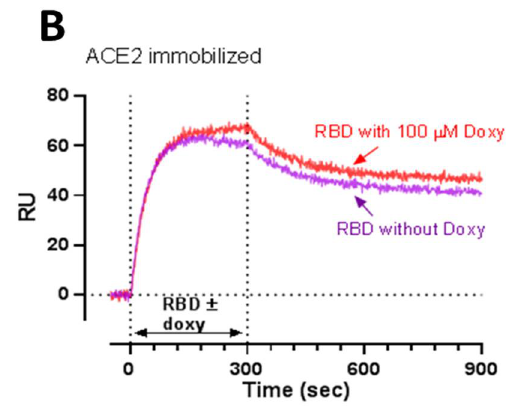
Figure 2. Surface plasmon resonance analysis showing no inhibitory effect of doxycycline on the ACE2-RBD interaction. ACE2-RBD interaction was evaluated either by flowing ACE2 (10 nM) over immobilized RBD ( A ) or, vice versa, RBD (60 nM) over immobilized ACE2 ( B ). This interaction was evaluated either in the absence or presence of 100 μM doxycycline. In particular, we preincubated the proteins for 60 min at room temperature with doxycycline or its vehicle, and then injected the mixture over the chip-immobilized protein binding partners for 300 s, as indicated. The graphs show the sensorgrams after subtraction of the SPR signal on reference surfaces (anti-Fc antibody for RBD; or anti-Flag antibody for ACE2). These are representative sensorgrams from one experimental session. Results were similar in three independent sessions.